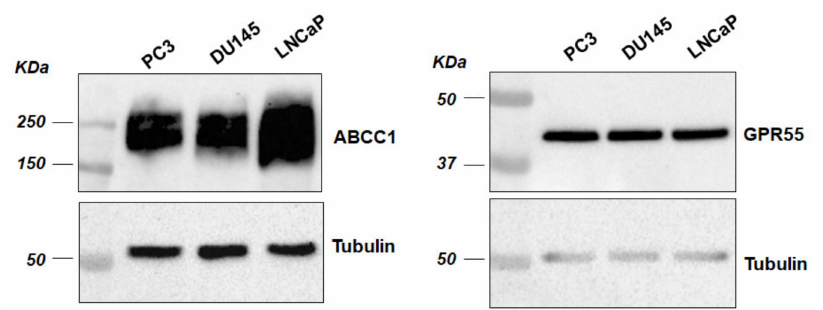
Figure 1. ATP Binding Cassette transporter C1 (ABCC1) and G protein-coupled receptor (GPR55) are expressed in prostate cancer cells. Expression of ABCC1 and GPR55 was assessed by Western blot analysis of lysates from the indicated prostate cancer cell lines. Membranes were stripped and re-incubated with anti-tubulin to confirm equal loading. The whole blot images can be found in Figure